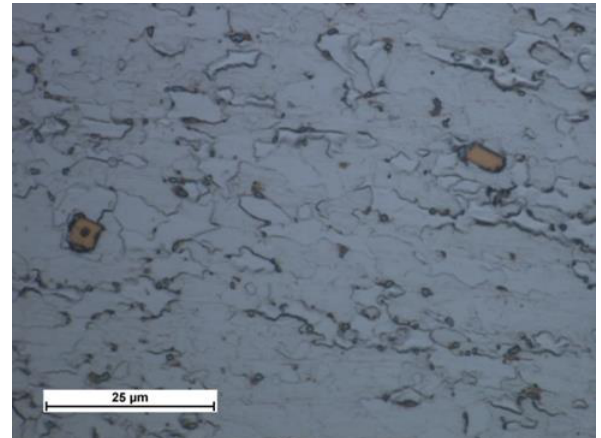
Figure 7. Characteristic sharp-shaped precipitate crystallised on impurity.